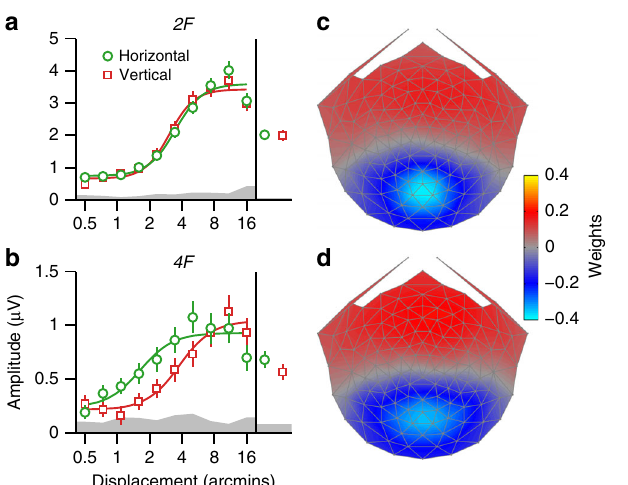
Fig. 5 Candidate MID signal from IOVD. Response functions for horizontal (green) and vertical (red) full-cue/full-reference anti-phase motion conditions, averaged across Experiments 1, 2, 3, and 4. Averages across all displacements are shown on the right side of the response functions. The response functions are from the fi rst reliable component of RCA done separately on 2F ( a ) and 4F ( b ) data, with the topographies shown on the right ( c , d ). The color scale indicates the component weights. Responses do not differ for the two directions of motion at 2F, but are different at 4F at the smaller displacements. An analogous analysis done on the uncorrelated and anti-correlated anti-phase conditions from Experiments 4 and 5 produced a similar pattern of results (see Supplementary Fig. 3). Error bars are ±1 SEM, smooth curves are Naka – Rushton fi ts and the gray band indicates the average EEG noise level